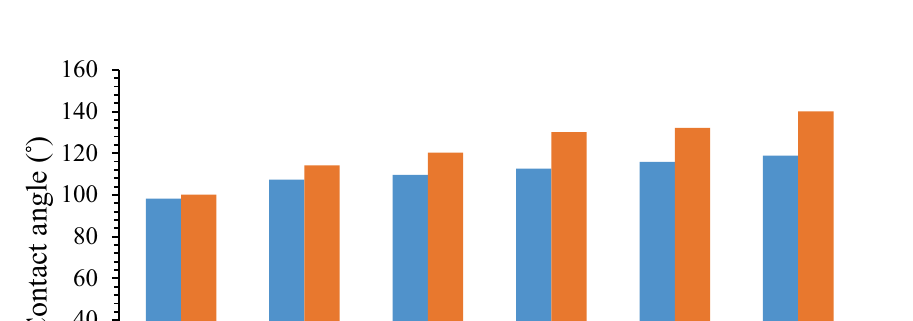
Table 5. Langmuir and Freundlich isotherm model constants.